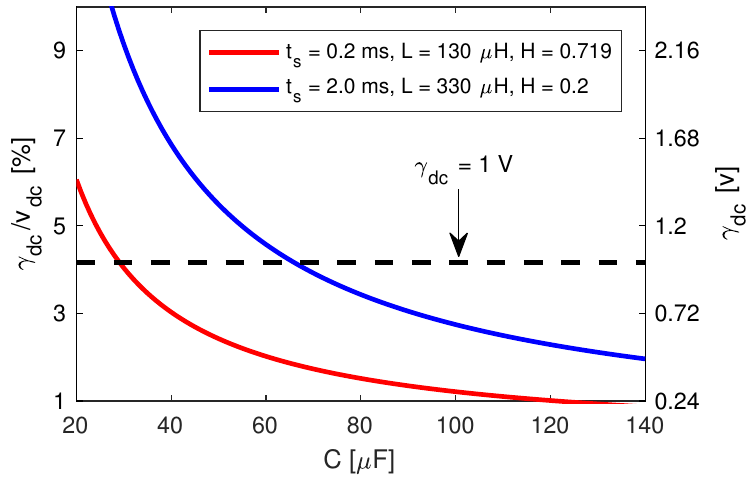
Figure 8. Example of capacitor design.